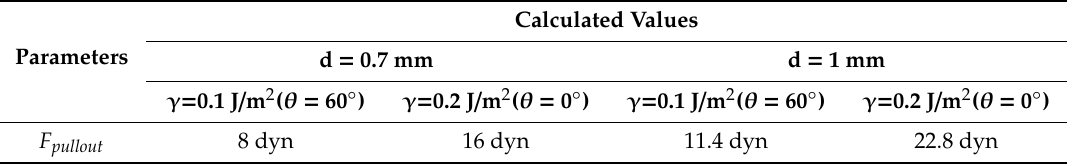
Table 2. The maximum force F pullout of the wet soil granular